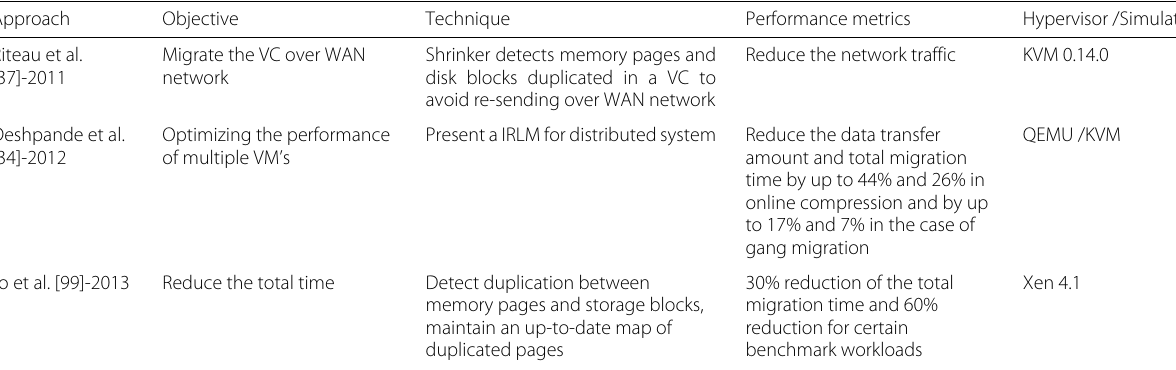
Table 7 Comparison of De-duplication based VM migration approaches